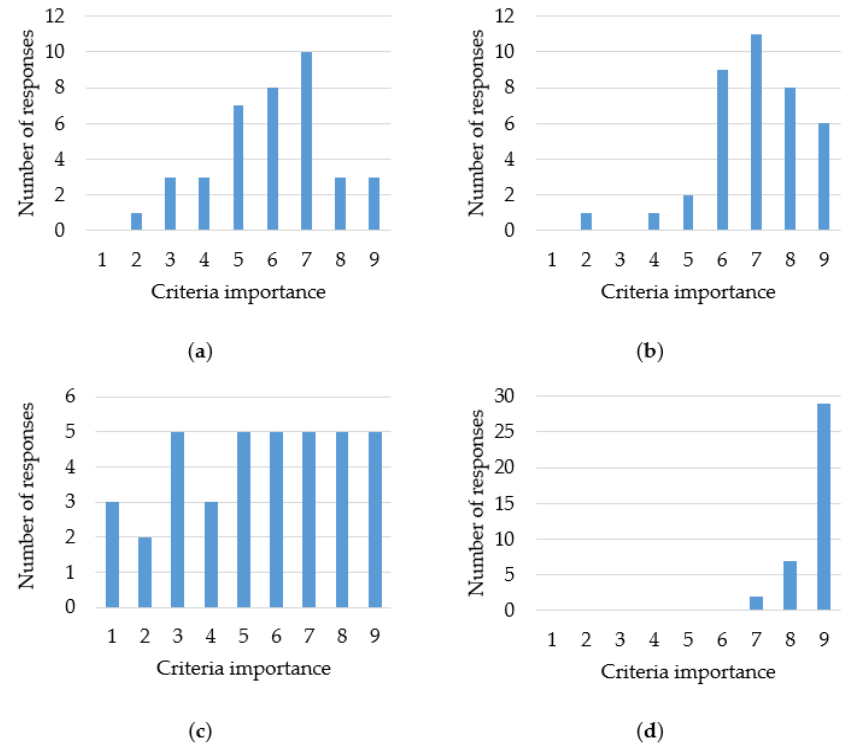
Figure 9. Probability distribution of responses for various criteria: ( a ) Maturity of technology, fit to a Normal distribution; ( b ) Limitations, fit to a Logistic distribution; ( c ) Environmental impact, fit to a Uniform distribution ( d ) Reduction of risk, fit to a Triangular distribution.